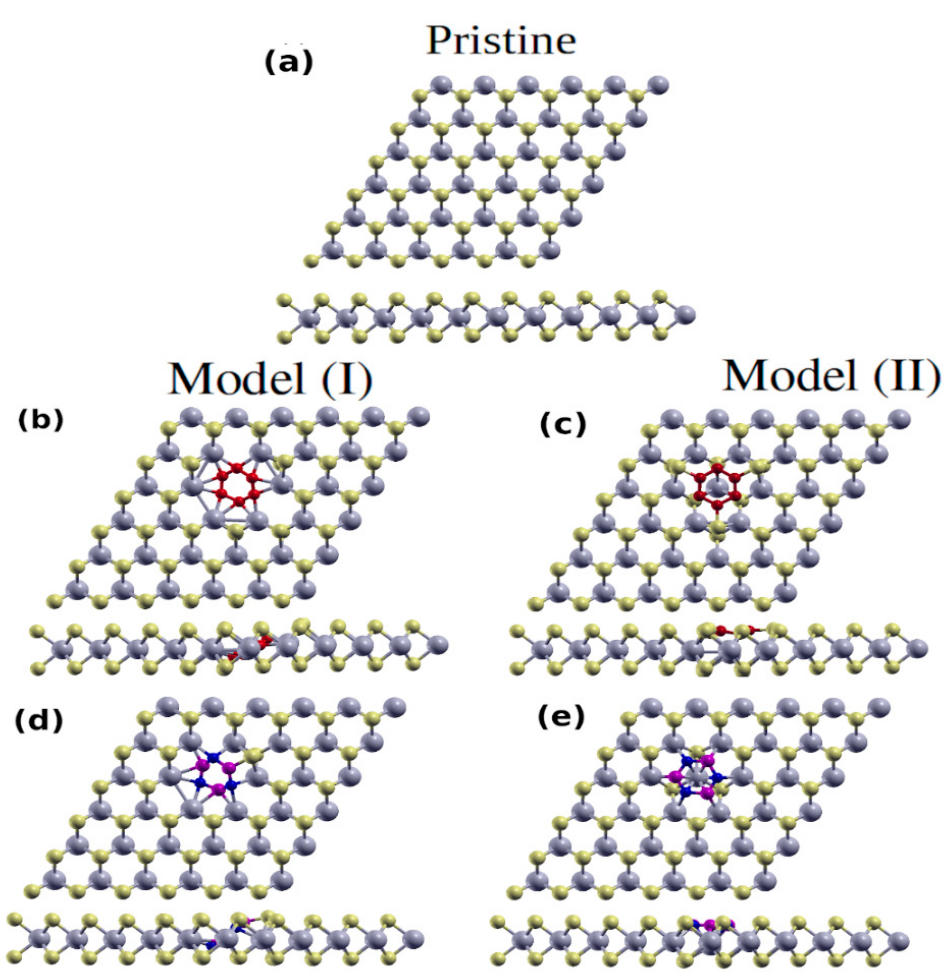
Figure 1. Top and side views of ( a ) pristine optimized structures of MoS 2 , ( b ) G@MoS 2 model I, ( c ) MoS 2 model II, ( d ) h-BN@MoS 2 model I, and ( e ) h-BN@MoS 2 model II.